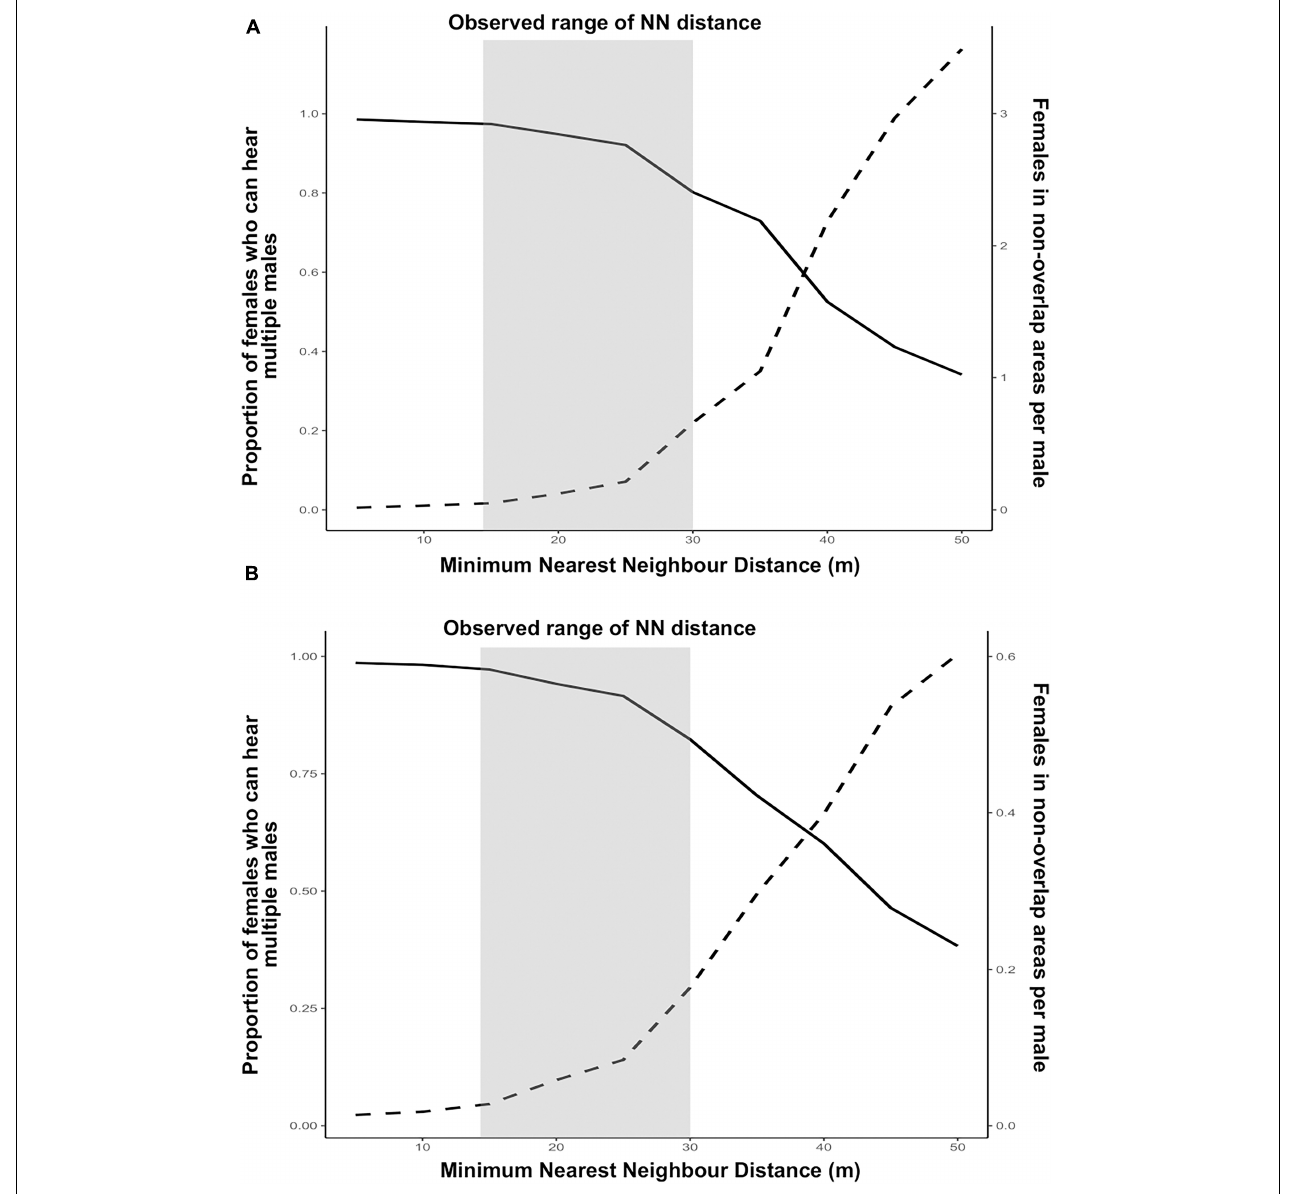
FIGURE 4 | Effect of male spacing on fitness of calling males and females under the assumptions of (A) one female to each Artocarpus tree and (B) females randomly distributed on Artocarpus trees with 1:1 sex ratio. Dotted lines represent females in non-overlap areas (male fitness) and solid lines represent proportion of females that can hear multiple males (female fitness/mate choice). The shaded region represents the observed range of distribution of nearest neighbour (NN) distances maintained by calling males in the field.